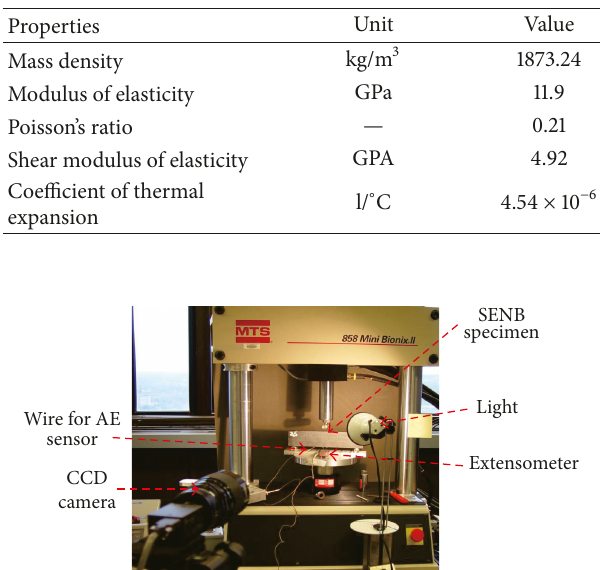
Table 1: Material properties of NBG-18 [24].